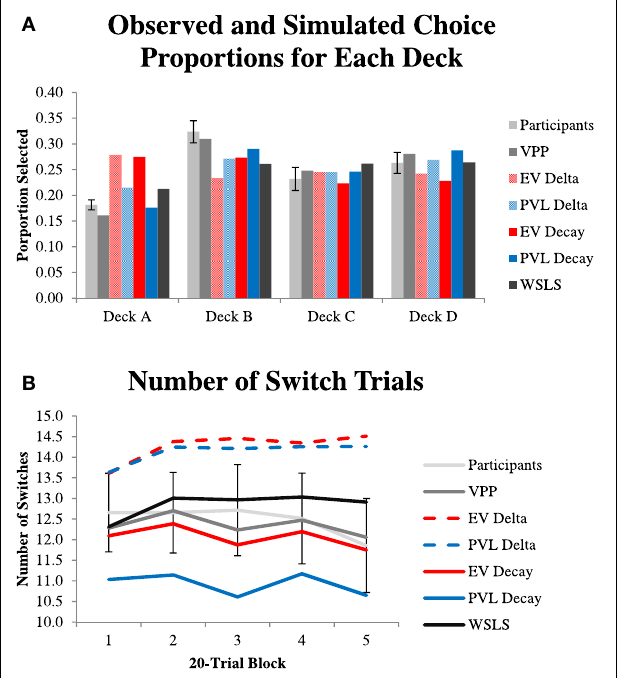
FIGURE 2 | (A) Observed and simulated choices of each deck. Simulations randomly sampled with replacement sets of the best-fitting parameters for participants for each model. (B) Number of “switch” trials where participants selected a different deck than the one selected on the previous trial in 20-trial